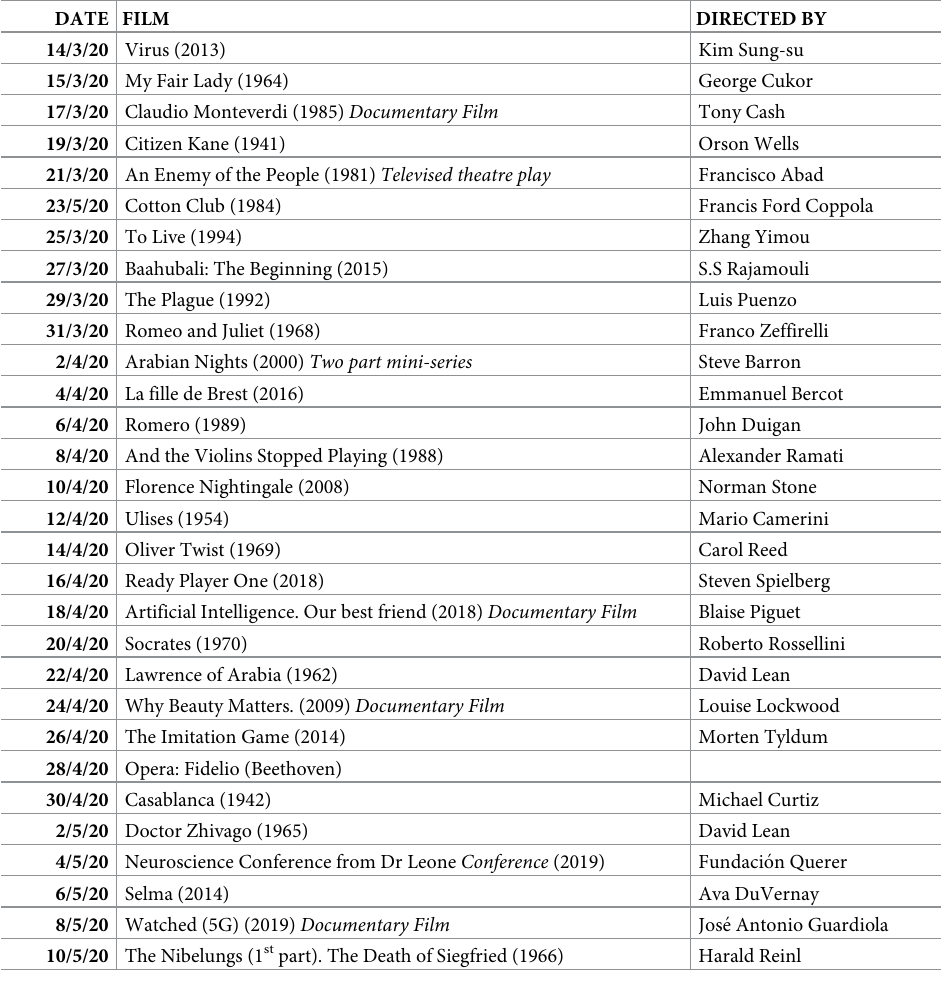
Table 1. Dialogic gathering of